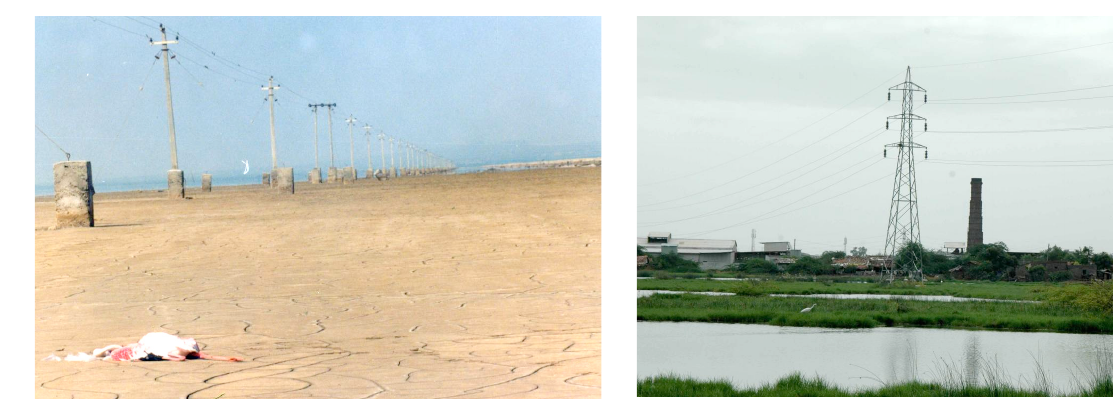
electricity (Sundar & Choudhury 2005; referred to as